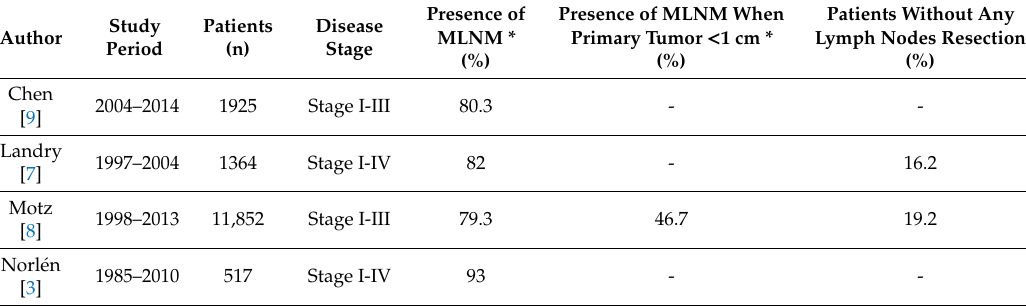
* when at least one lymph node was